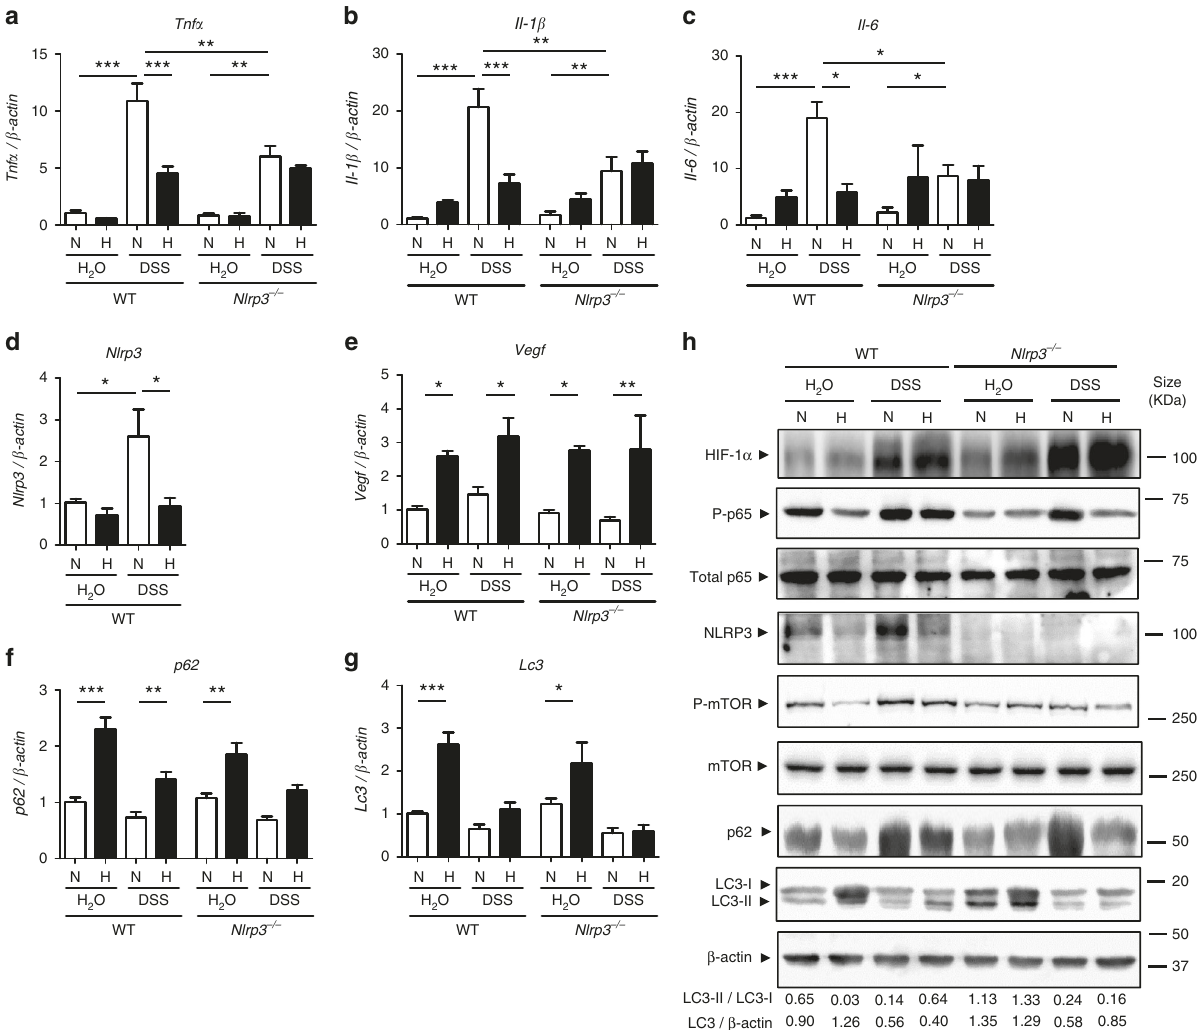
Fig. 2 Hypoxia reduces in fl ammatory processes and induces autophagy in the DSS mouse model of colitis. a , b , c , d , e , f and g WT and Nrlp3 − / − mice were administered with DSS or DSS-free water and subjected to normoxia (N, 21% O 2 ) or hypoxia (H, 8% O 2 ). After 18 h, mice were killed and colon biopsies were collected. Statistical analysis was performed using one-way ANOVA followed by Tukey ’ s post-test. Results represent mean + s.e.m., WT mice under normoxia: n = 5, WT mice under normoxia: n = 5, DSS-treated WT mice under normoxia: n = 6; Nrlp3 − / − mice under normoxia: n = 5; DSS-treated Nrlp3 − / − mice under normoxia: n = 6; WT mice under hypoxia: n = 4, DSS-treated WT mice under hypoxia: n = 5; Nrlp3 − / − mice under hypoxia: n = 3; DSS-treated Nrlp3 − / − mice under hypoxia: n = 3, * P < 0.05; ** P < 0.01; *** P < 0.001. h Total protein was isolated and western blot performed. LC3-I and LC3-II bands were quanti fi ed, and autophagy was measured by variations in the ratio of LC3-II/LC3-I and the total amount of LC3 (LC3-I plus LC3-II) relative to β -actin